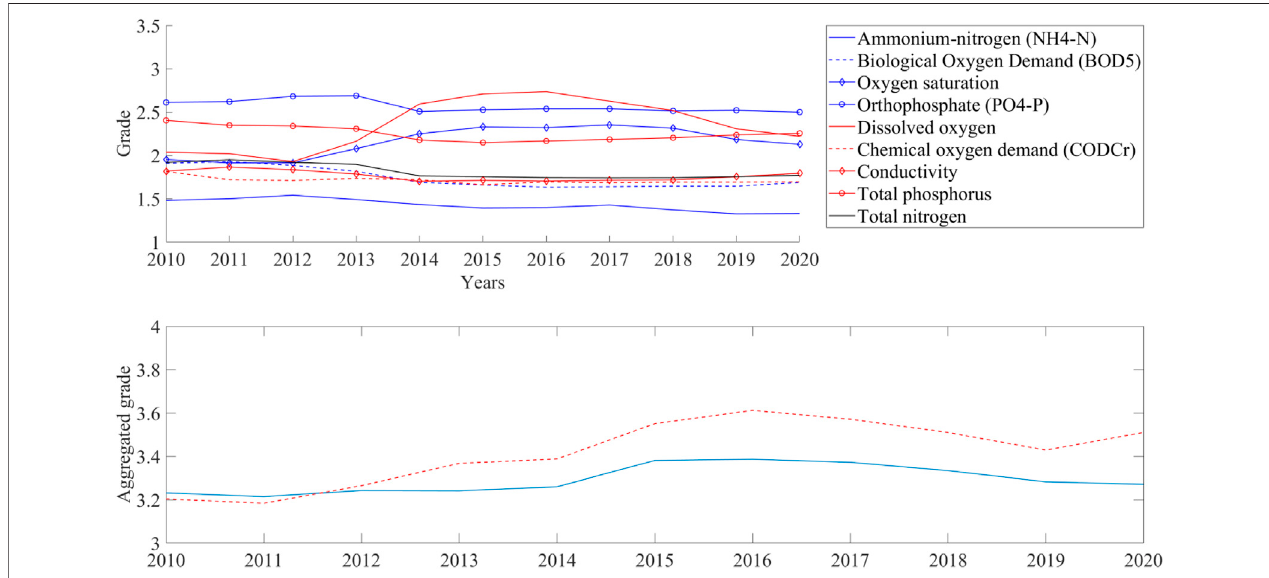
FIGURE 12 | The annual average quality of watercourses (1-Excellent/Good, 2-Good/Moderate, 3-Moderate/Weak, 4-Weak/Bad) according to the Hungarian RBMP.